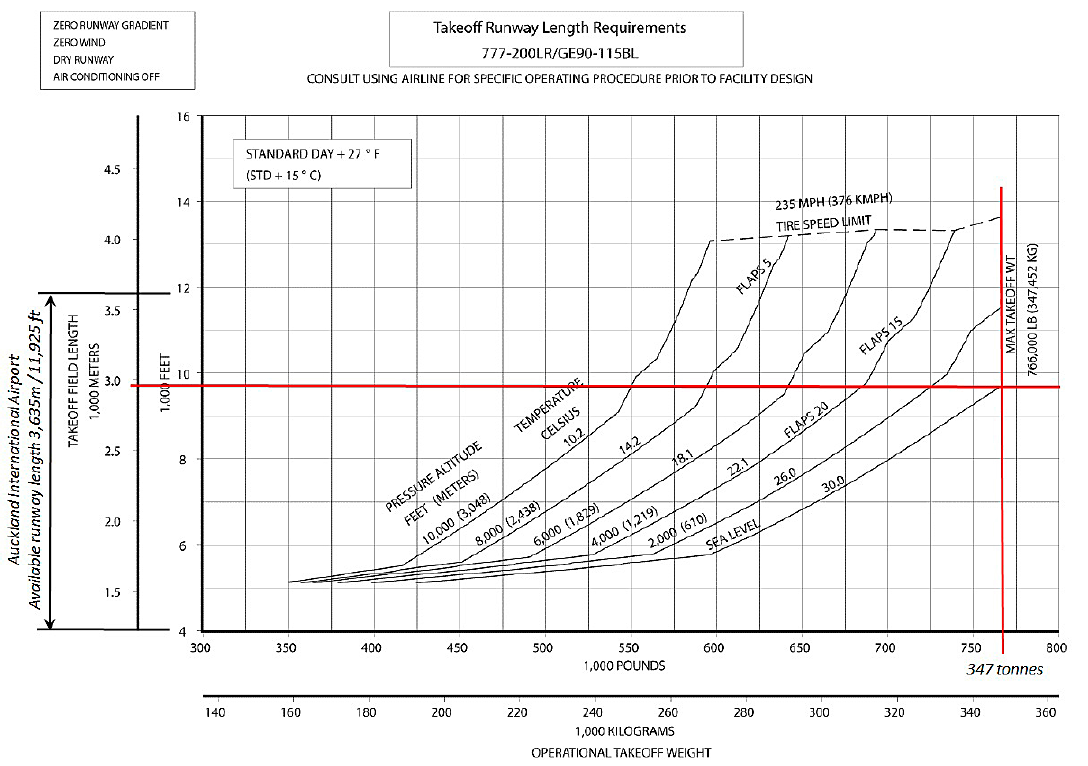
Fig. 3. F.A.R. Takeoff Runway Length Requirements – standard day with +15 °C: model 777–200LR (GE90–115B Engines) (Boeing Commercial Airplanes 2009). Permission obtained from Boeing to reproduce this figure – copyright ©